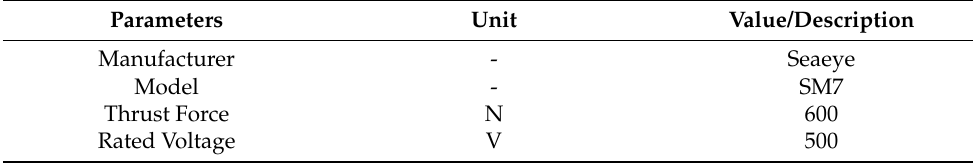
Table 7. Thruster specification.